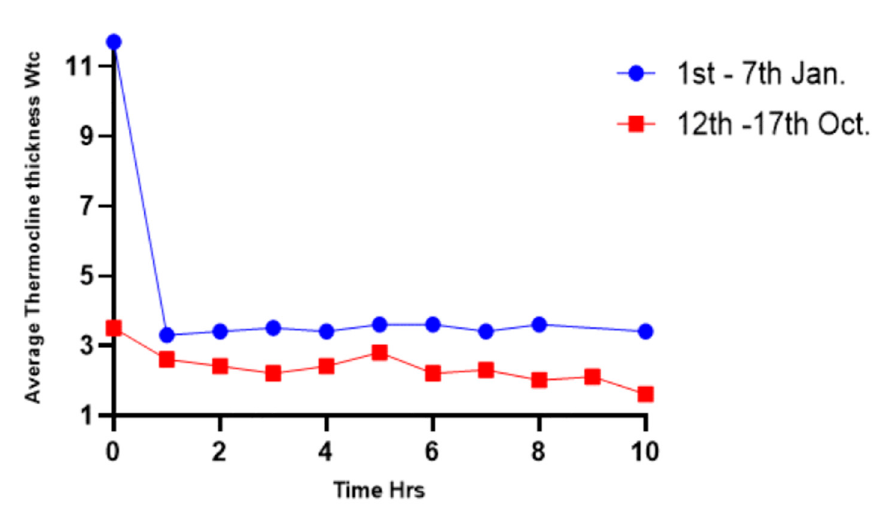
Figure 6. Average thermocline thickness (WTc) with time.